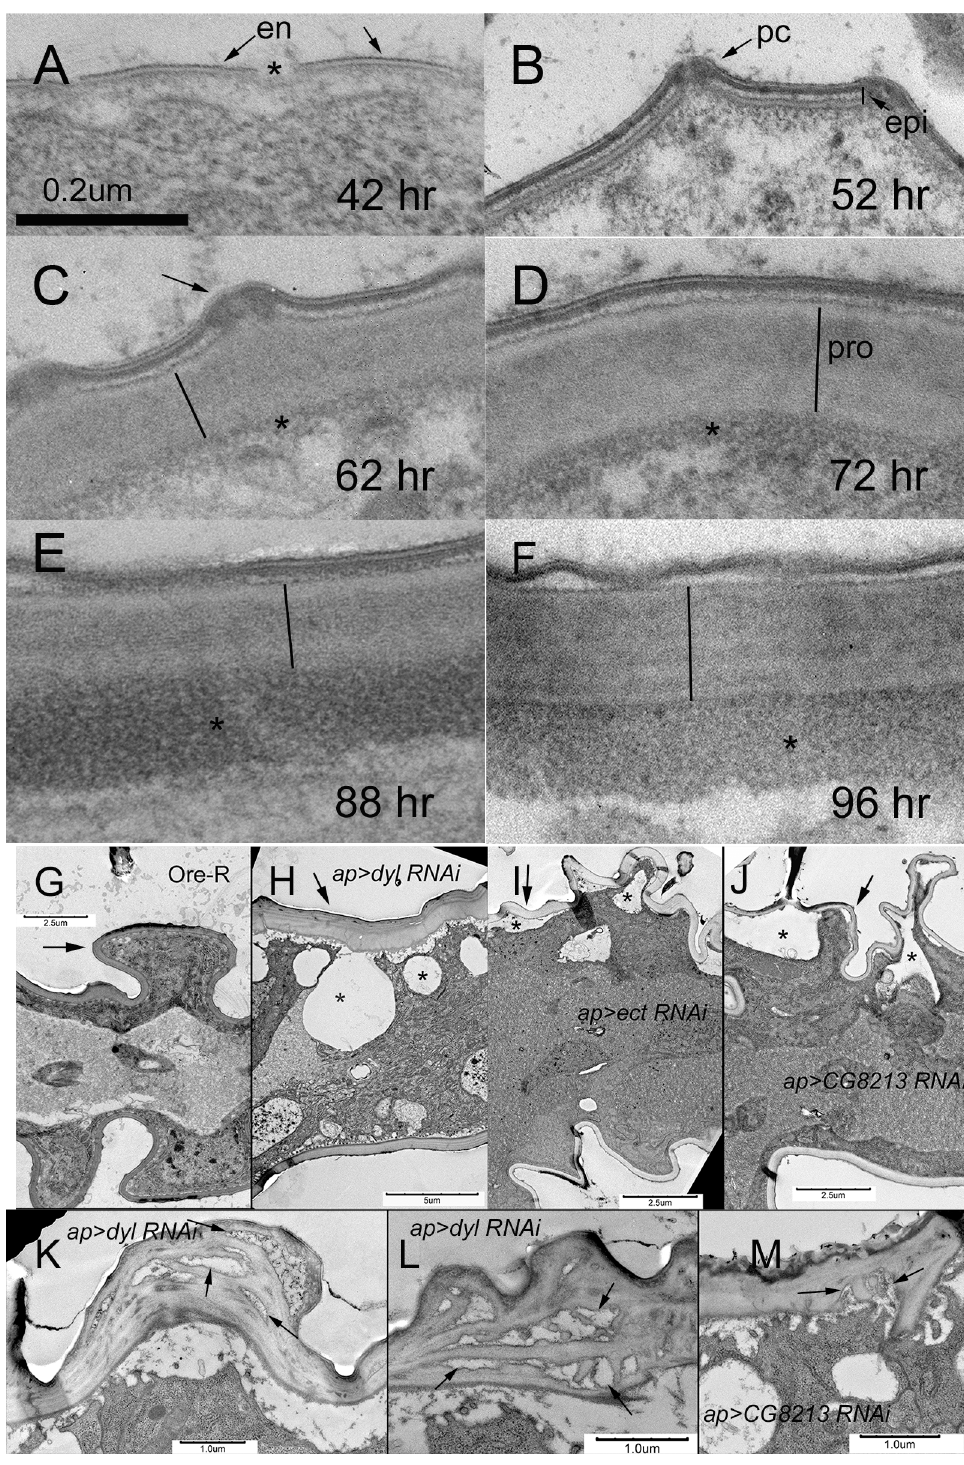
Fig 2. Transmission electron micrographs of wing cuticle deposition. Panels A-F are all shown at the same magnification. The time is for pupae collected as white prepupae and aged at 25°C. Panel A. In 42 hr awp wings the deposition of the envelope (en) is visible (arrows). Gaps remain where the envelope does not cover the surface (asterisk). B. In 52 hr awp wings the epicuticle (epi) is now visible (line) and pore canals are prominent (arrows — pc). C. In 62 hr wings procuticle is now obvious (line). Pore canals remain